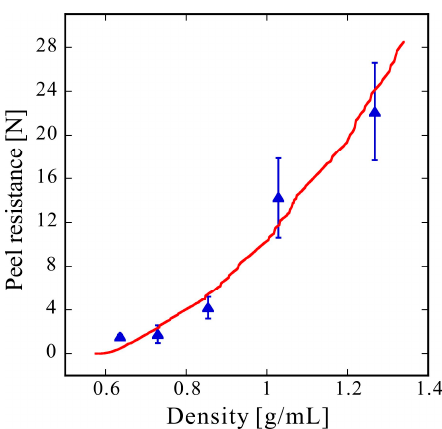
Figure 7. Experimental and simulation results. Blue triangles represent experimental results. Error bars indicate the standard deviation. The red line represents the simulation results obtained using the cross-sectional analysis model developed in this work.